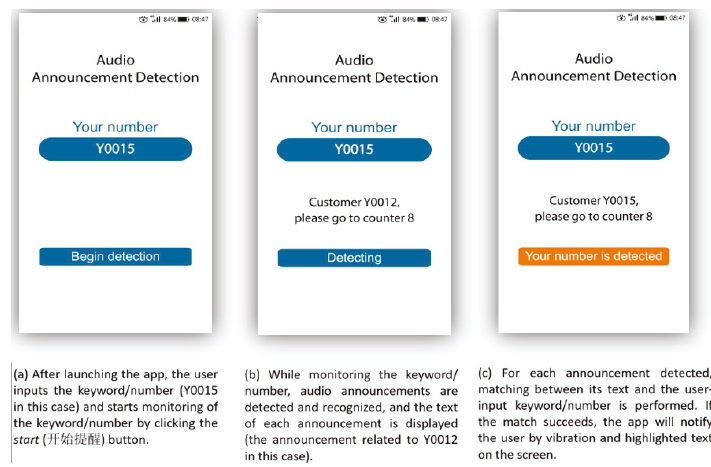
Figure 3: Screen shot of the